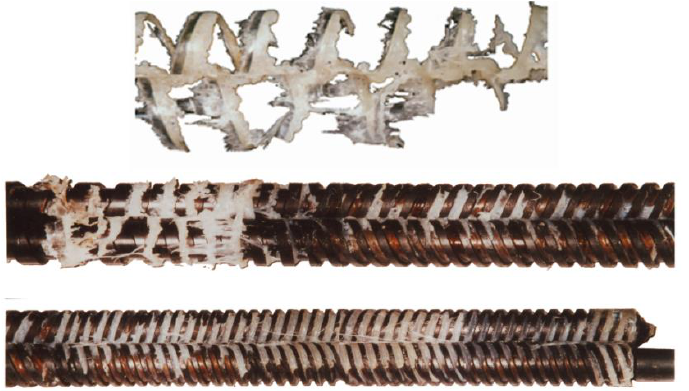
Figure 5. Melting mechanism observed in counter-rotating twin screw extrusion [74].